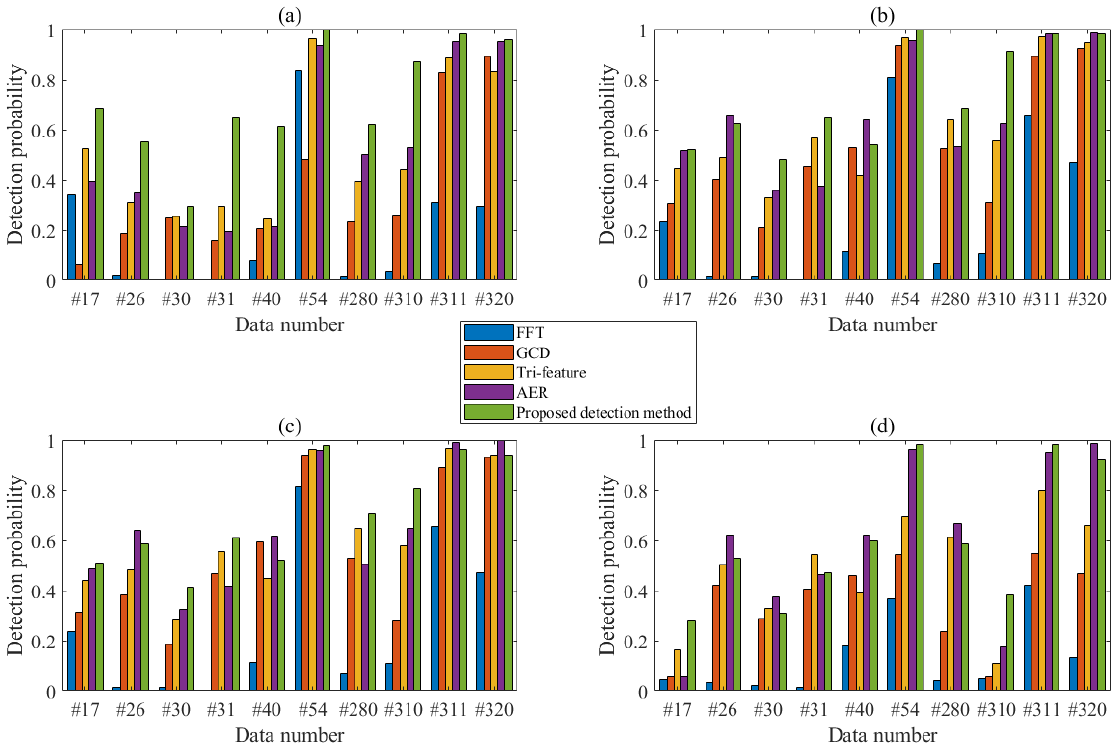
Figure 7. Contrasts of detection probabilities of five detection methods at ( a ) HH, ( b ) HV, ( c ) VH and ( d ) VV, when N = 1024 and P fa = 10 − 3 .